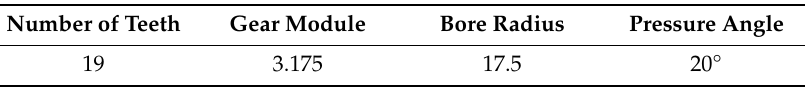
Table 3. A pair of gears with the transmission ratio